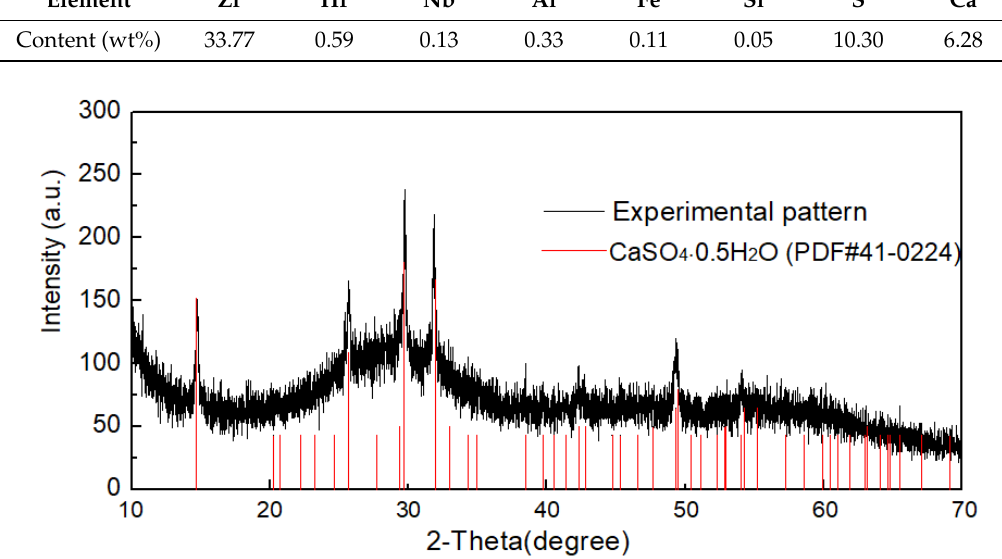
Figure 10. XRD pattern of the basic zirconium sulfate precipitate.